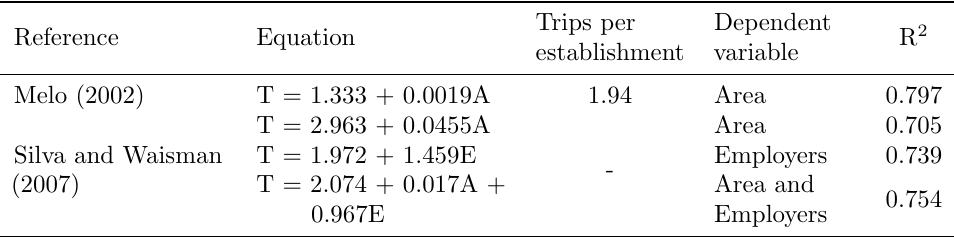
Table 1: Trip generation models to pubs and restaurants in Brazilian context